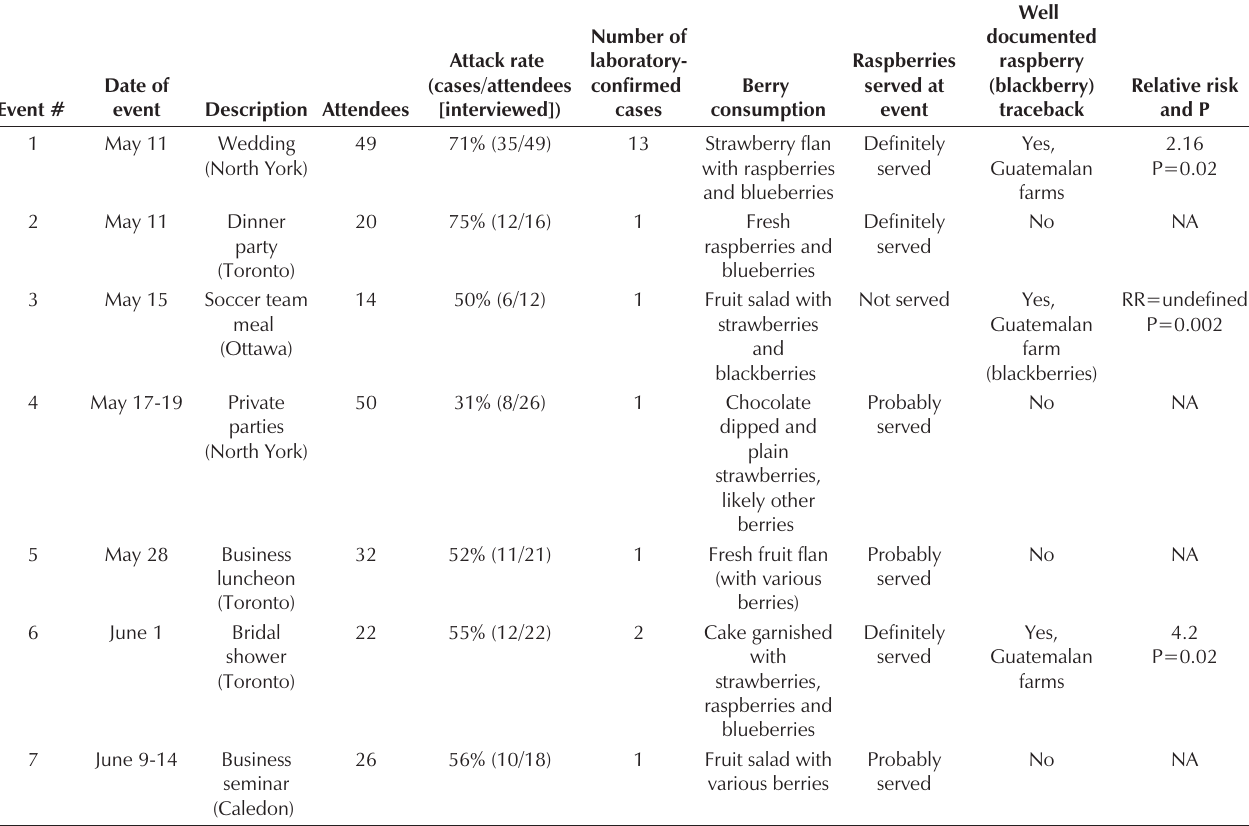
Summary of the seven clusters of cyclosporiasis in Ontario, 1996 (by event date)